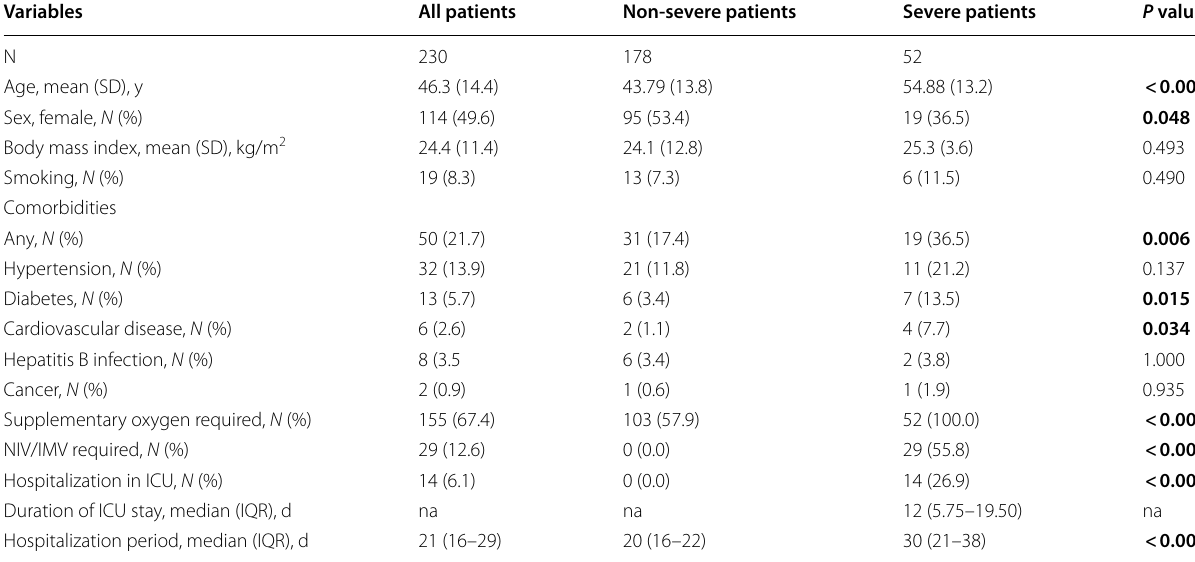
SD standard deviation; IQR interquartile range; NIV non-invasive mechanical ventilation; IMV invasive mechanical ventilation; na not available